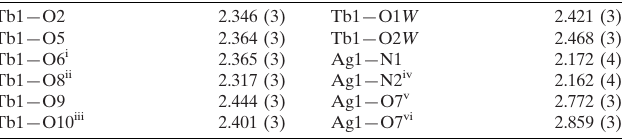
Selected bond lengths (A˚